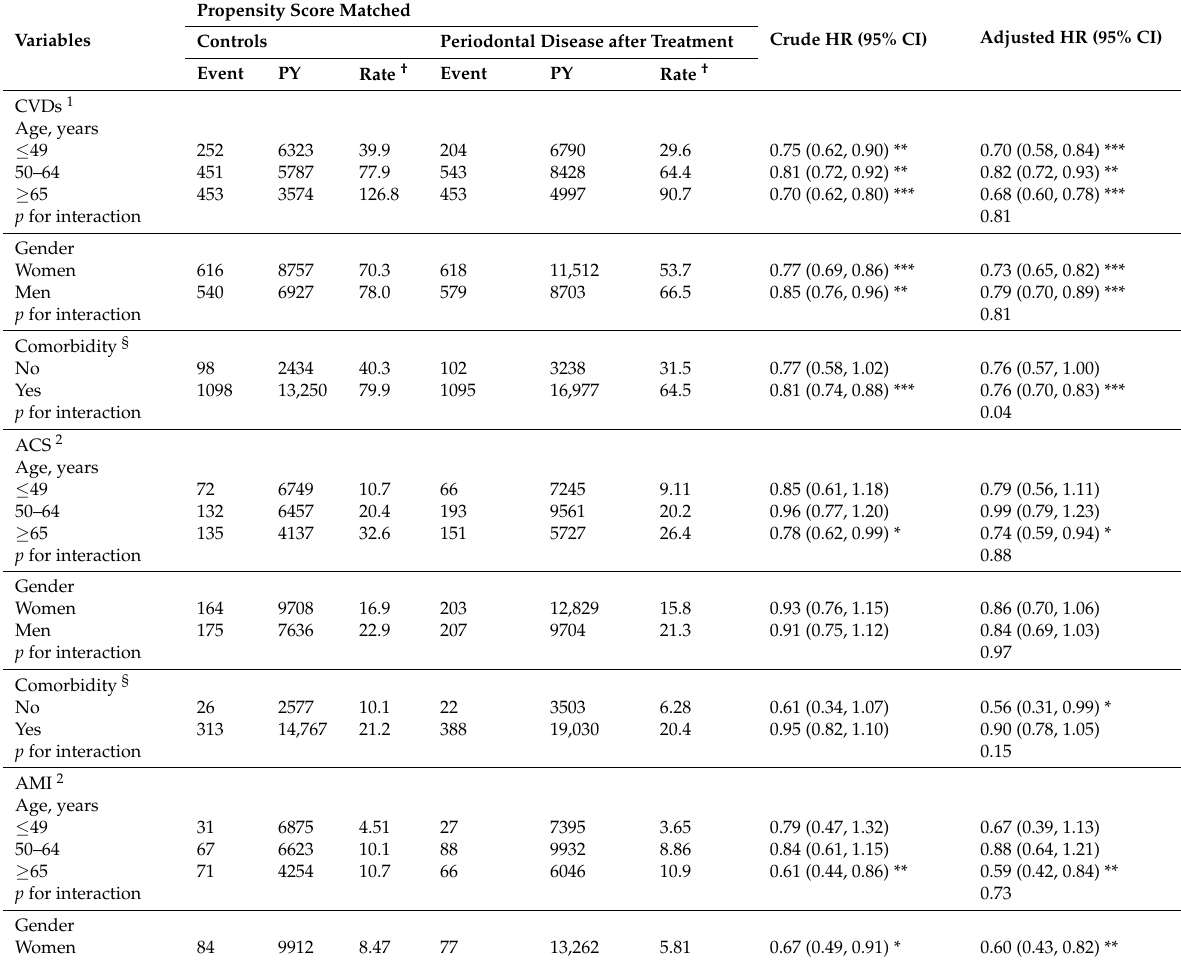
Table 4. Matched Cox proportional hazards model measured hazard ratios (HRs) and 95% confidence intervals (CIs) of outcomes of patients with periodontal disease after treatment and patient without POD by age, gender, and